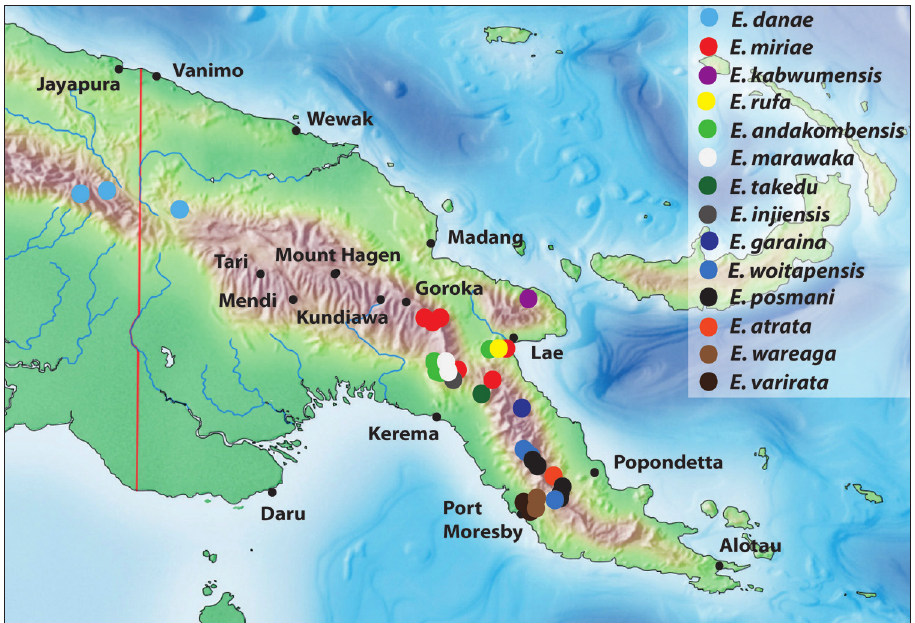
Figure 40. Map of Papua New Guinea showing distribution of species of the Exocelina danae